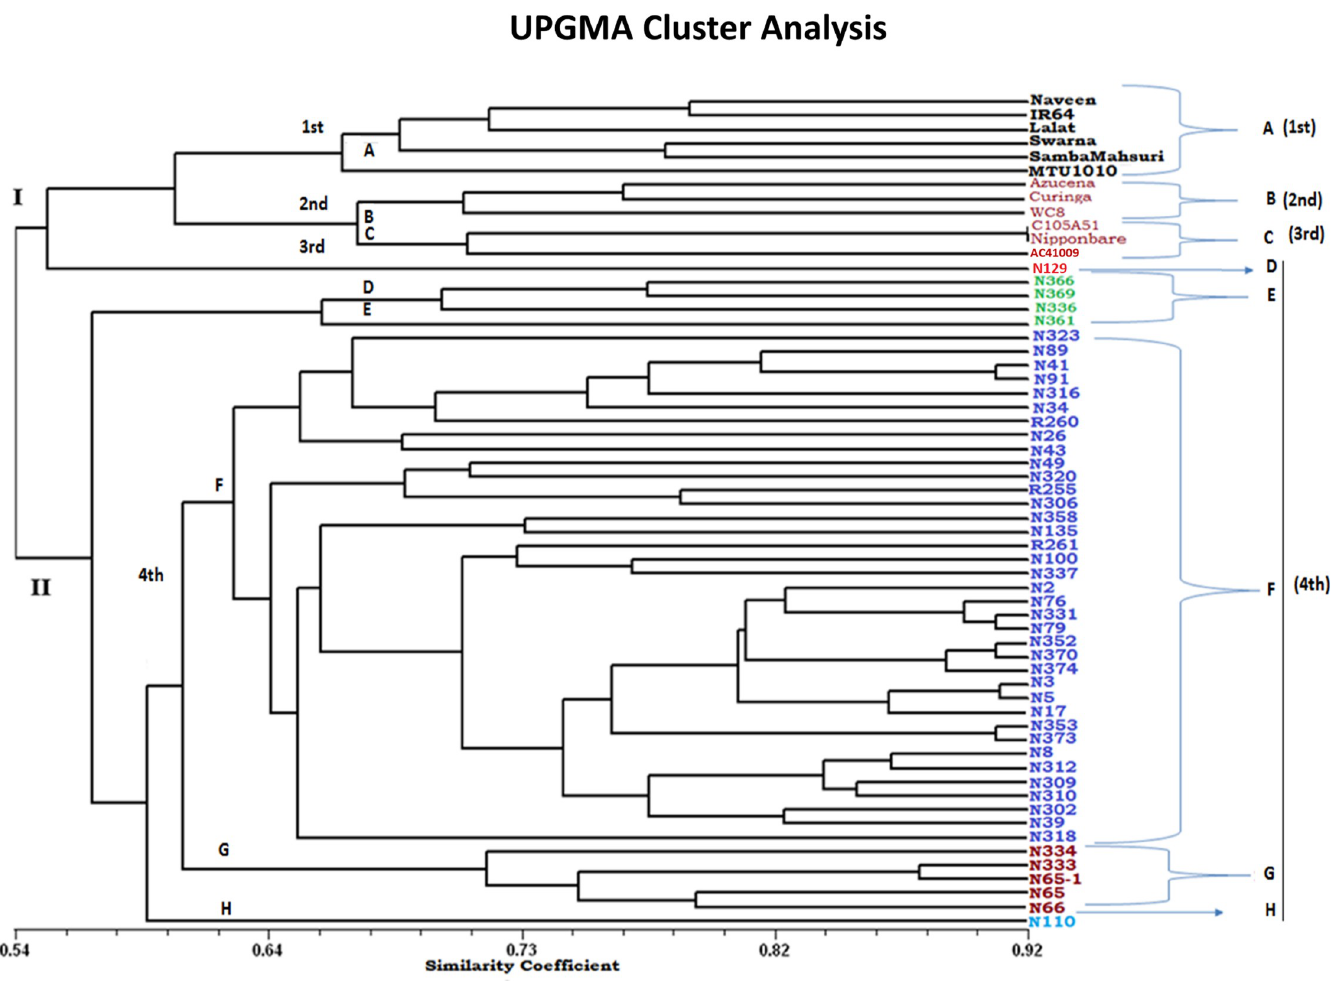
Fig 5. The genotypes clustering based on UPGMA analysis. The 60 genotypes were assigned into four groups (A-1st, B-2nd, C-3rd, and D, E, F, G, H-4th) and similarity varied between 0.54 to 0.92%.